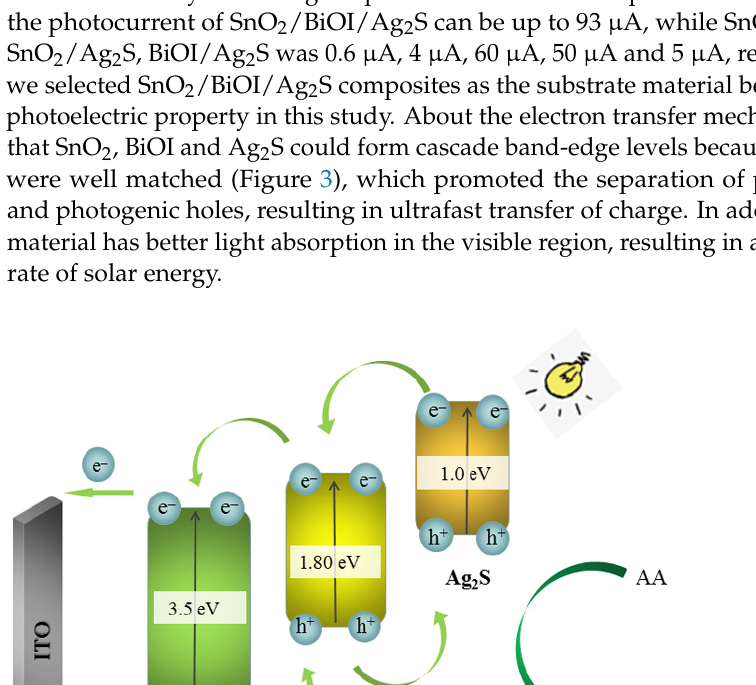
5 of 10 Figure 2. SEM images of SnO 2 ( A ), BiOI ( B ), SnO 2 /BiOI ( C ), SnO 2 /BiOI/Ag 2 S ( D ). Figure S2 shows the absorption of ultraviolet and visible light by the as-prepared